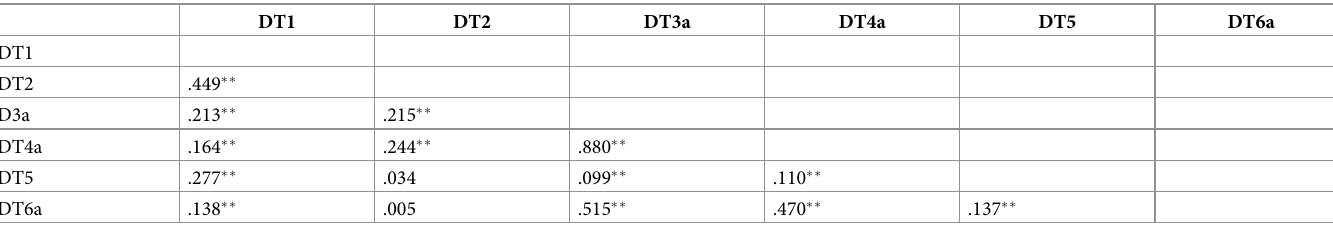
Table 9. Matrix of correlation between variables on